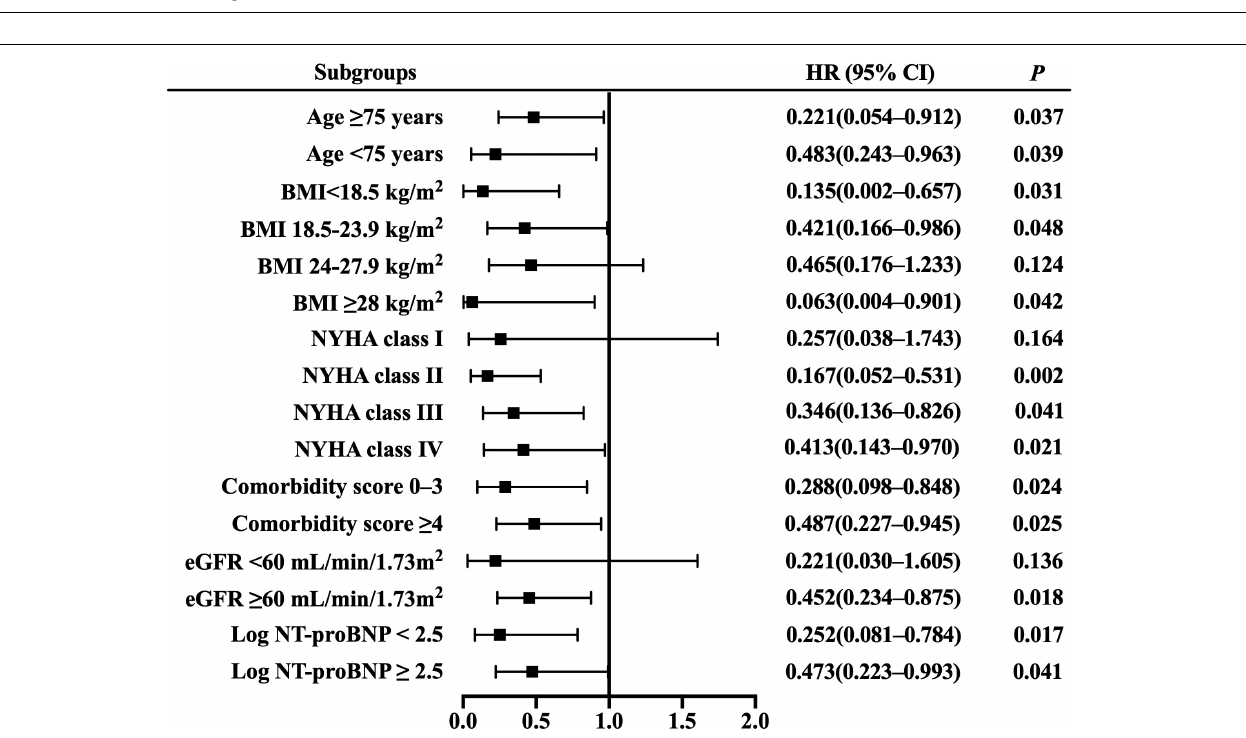
FIGURE 3 | Resting cardiac power/mass for the prediction of all-cause mortality: subgroup analysis. The prognostic value of resting cardiac power/mass is considered in several patient subgroups, after adjustment for age, gender, BMI, NYHA class, LVEF, comorbidity score, eGFR, log NT-proBNP, ACEI/ARB, beta blocker, and aldosterone antagonist. Other abbreviations as in Table 1 .